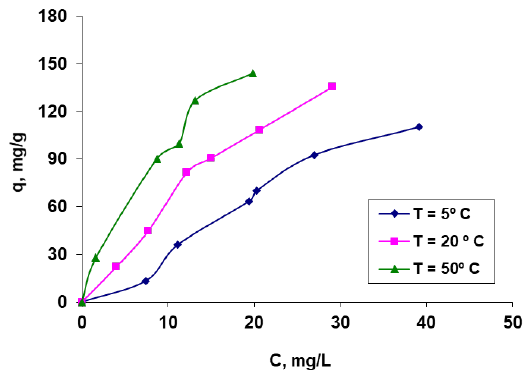
Figure 7. The biosorption isotherms of Methylene Blue dye on hydrogel OxC25. Conditions: pH = 11, contact time = 24 h, amount of biosorbent = 0.44 g/L.